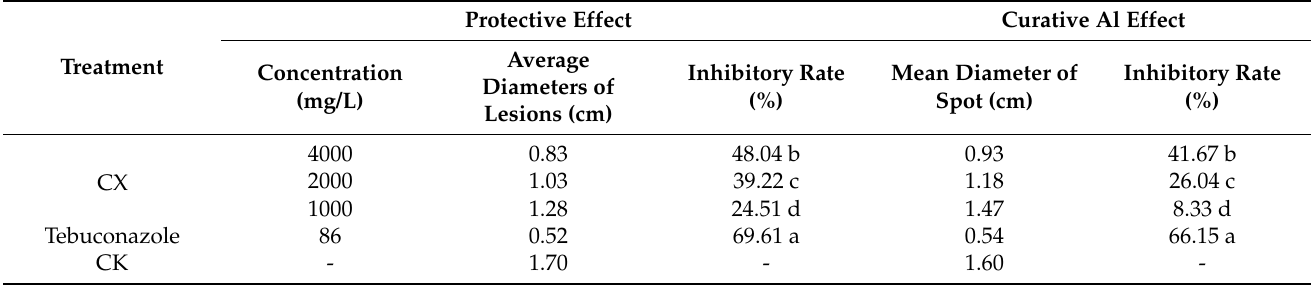
Table 5. In vivo control effect of CX plant extracts on Colletotrichum gloeosporioides .